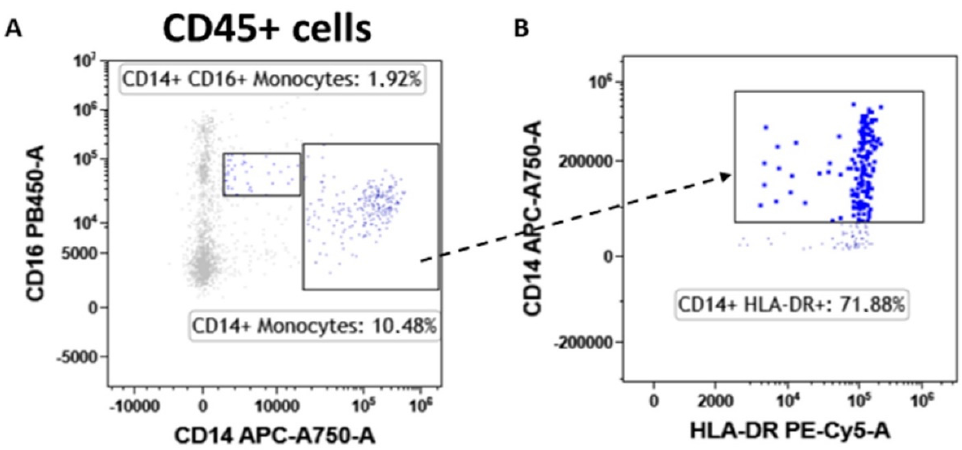
Figure 8. Monocyte subtype gating strategy. Inside the CD45 pos cells, we selected monocytes as CD14 pos events and atypical monocytes (CD14 pos /CD16 pos ) ( A ). Monocytes were also assessed for their level of activation by determining the expression levels of HLA-DR ( B ). Table 4. Statistical values of the monocyte subsets. Values are reported as the median percentage of gated cells .